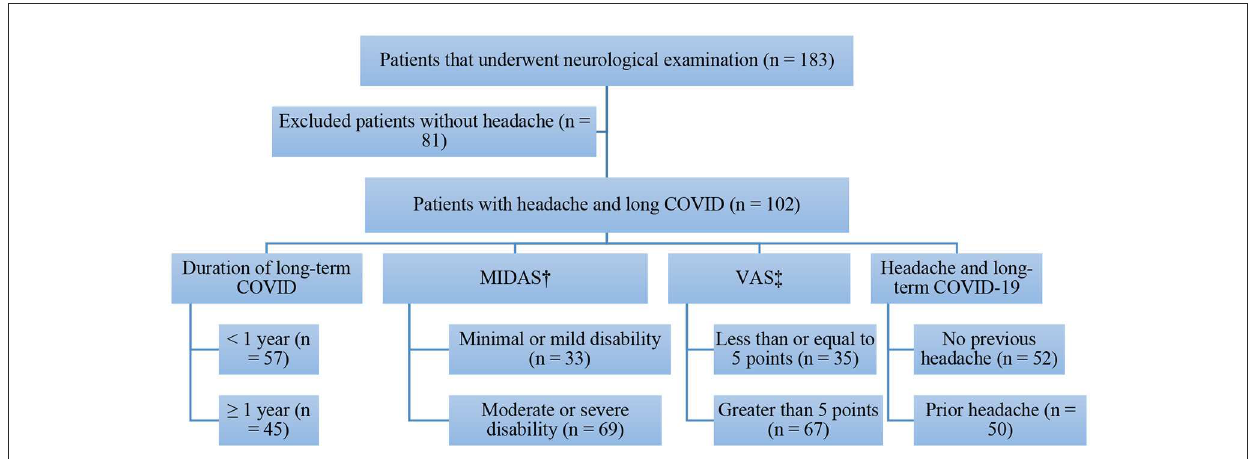
FIGURE1 Flowchart of patients who had headache with long-term COVID-19 in the present study. Source: Authors themselves, 2020–2021. † Migraine Disability Assessment. ‡ Visual Analog Pain